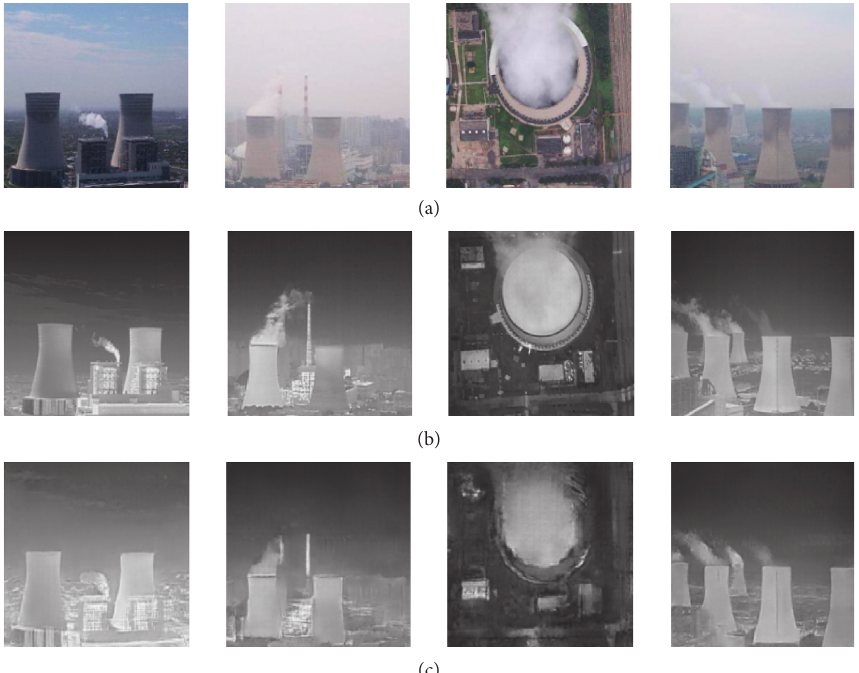
Figure 7: Examples of infrared-generated images of cooling towers produced on the basis of the I-GANs algorithm. (a) Visible images. (b) Real infrared images. (c) Infrared-generated